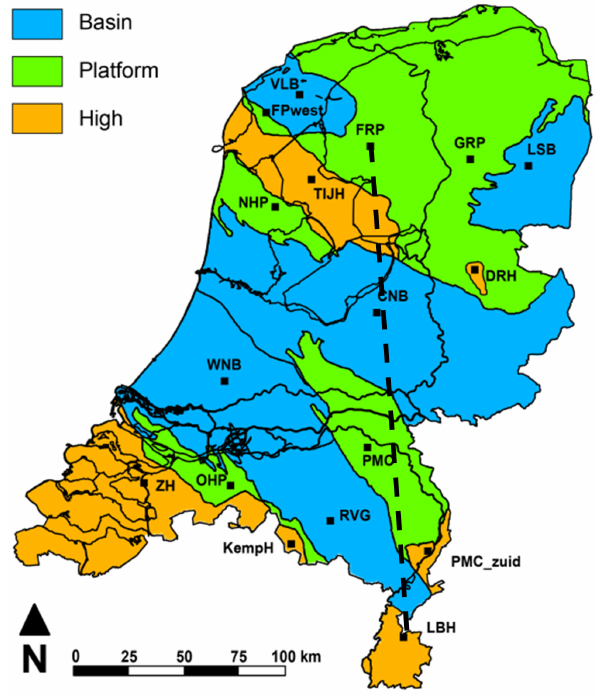
Figure 1. Structural elements in the Dutch subsur- face. LBH = Limburg High, RVG = Ruhr Valley Graben, KempH = Kempisch High, ZH = Zeeland High, OHP = Oosterhout Platform, PMC = Peel-Maasbommel, PMC_zuid = Peel- Maasbommel High, WNB = West Netherlands Basin, CNB = Central Netherlands Basin, DRH = Drenthe High, NHP = Noord Holland Platform, TIJH = Texel-IJsselmeer High, FRP = Friesland Platform, FP (west) = Friesland Platform, VLB = Vlieland Basin, GRP = Groningen Platform, LSB = Lower Saxony Basin. Dashed line refers to the profile shown in Fig.